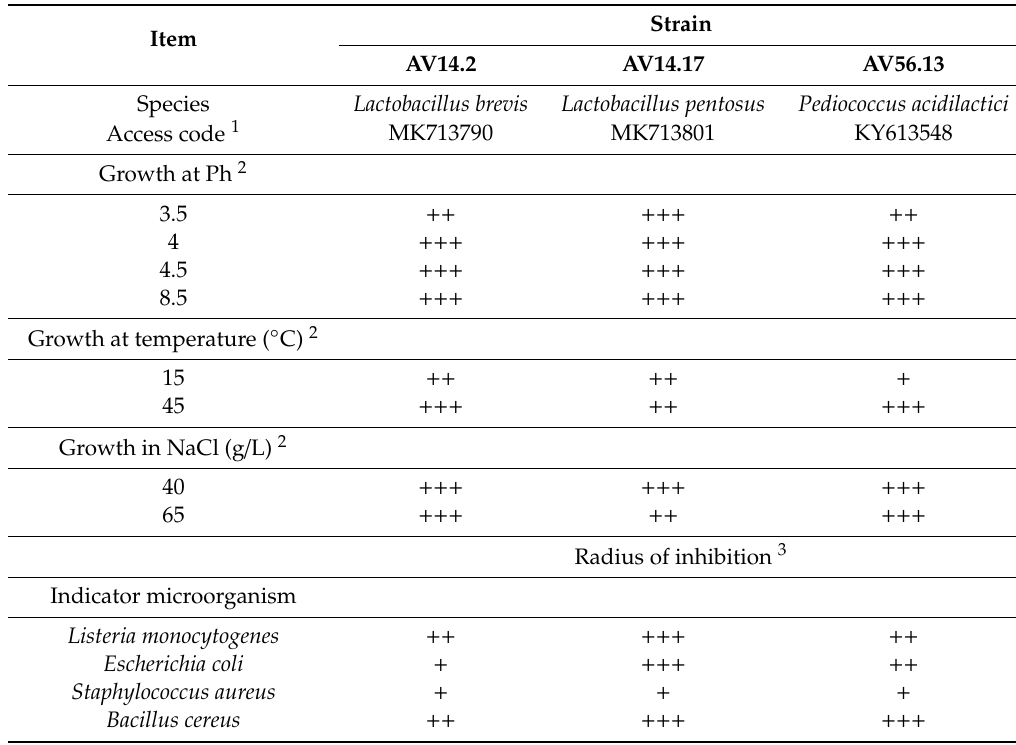
Table 2. Phenotypic characteristics and antimicrobial activity of lactic acid bacteria strains isolated from alfalfa